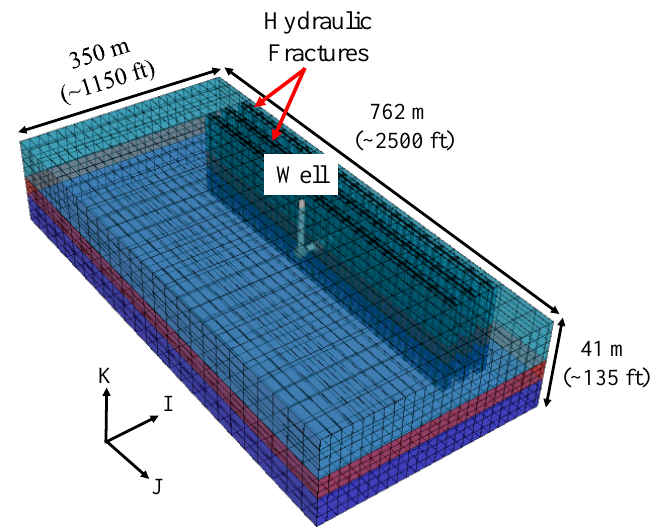
Figure 1. Reservoir model